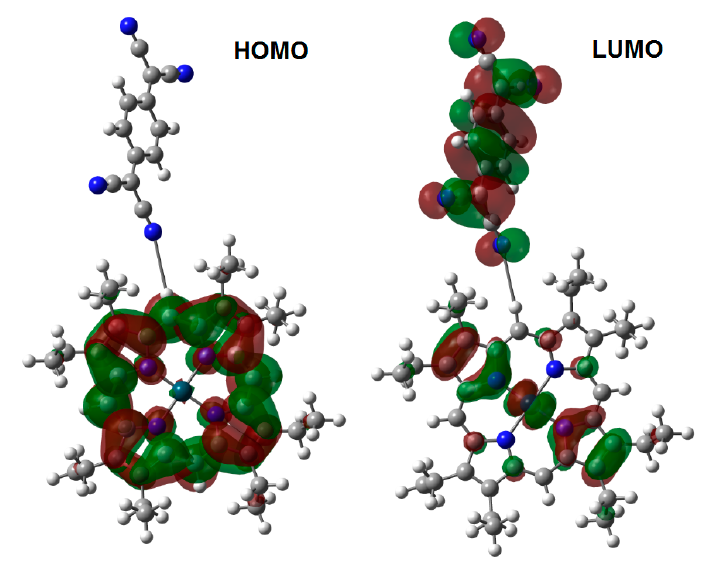
Figure 4. Frontier molecular orbitals of the cobalt(II) porphyrin complex with hydrogen bonds with an aromatic source.